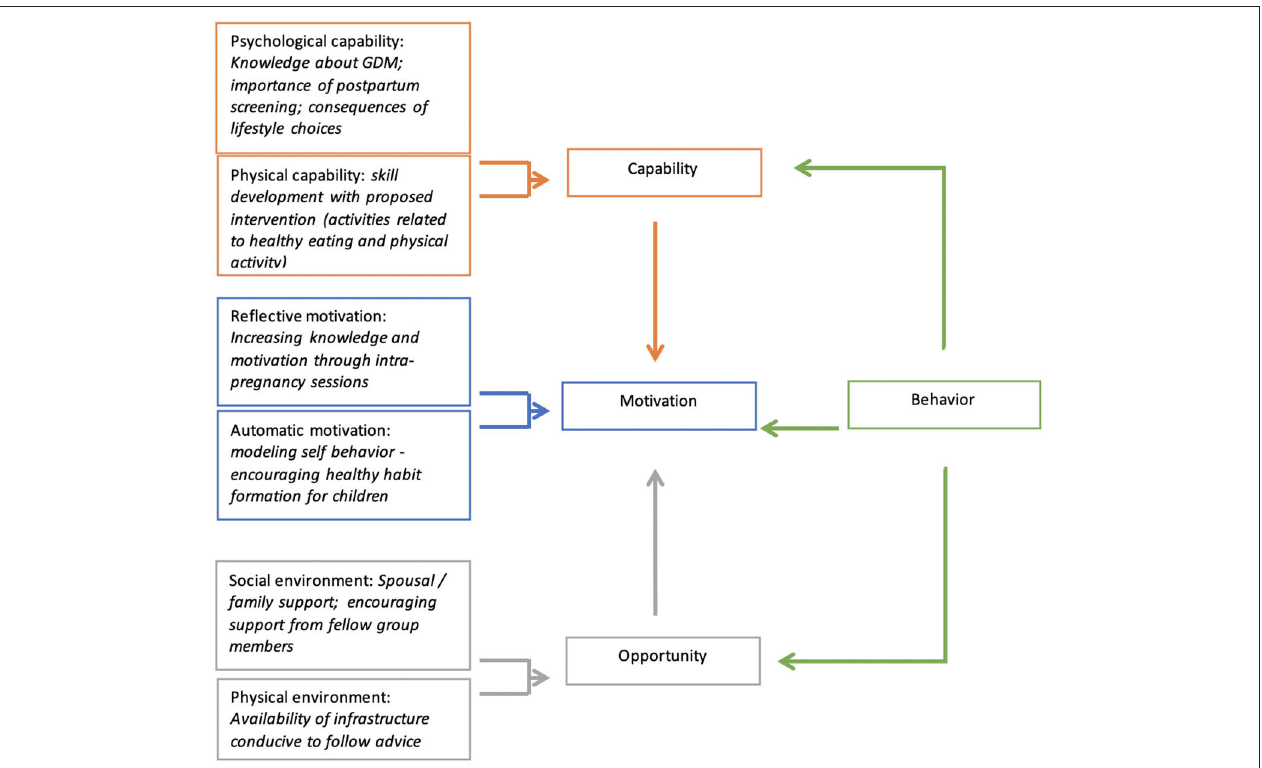
FIGURE 1 | Applying the constructs of the COM-B behavior change framework to the themes generated in the